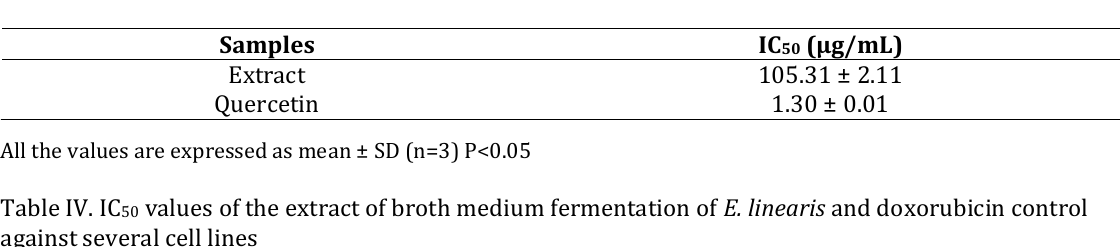
Figure 5. GC-MS profile of ethyl acetate extract of broth medium fermentation of E. linearis Table III. IC 50 value of the extract of broth medium fermentation of E. linearis in DPPH scavenging assay